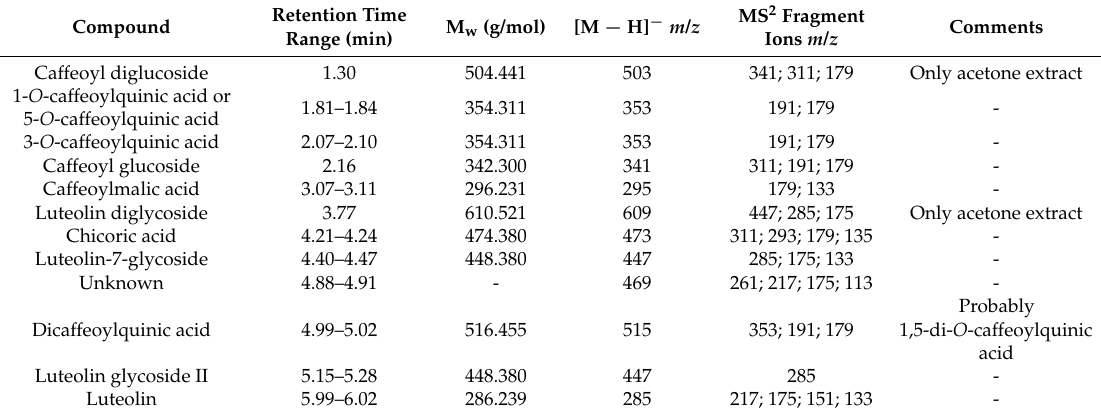
Table 3. UHPLC-MS identification of main polyphenol compounds in Taraxacum officinale leaves extracts. Compound